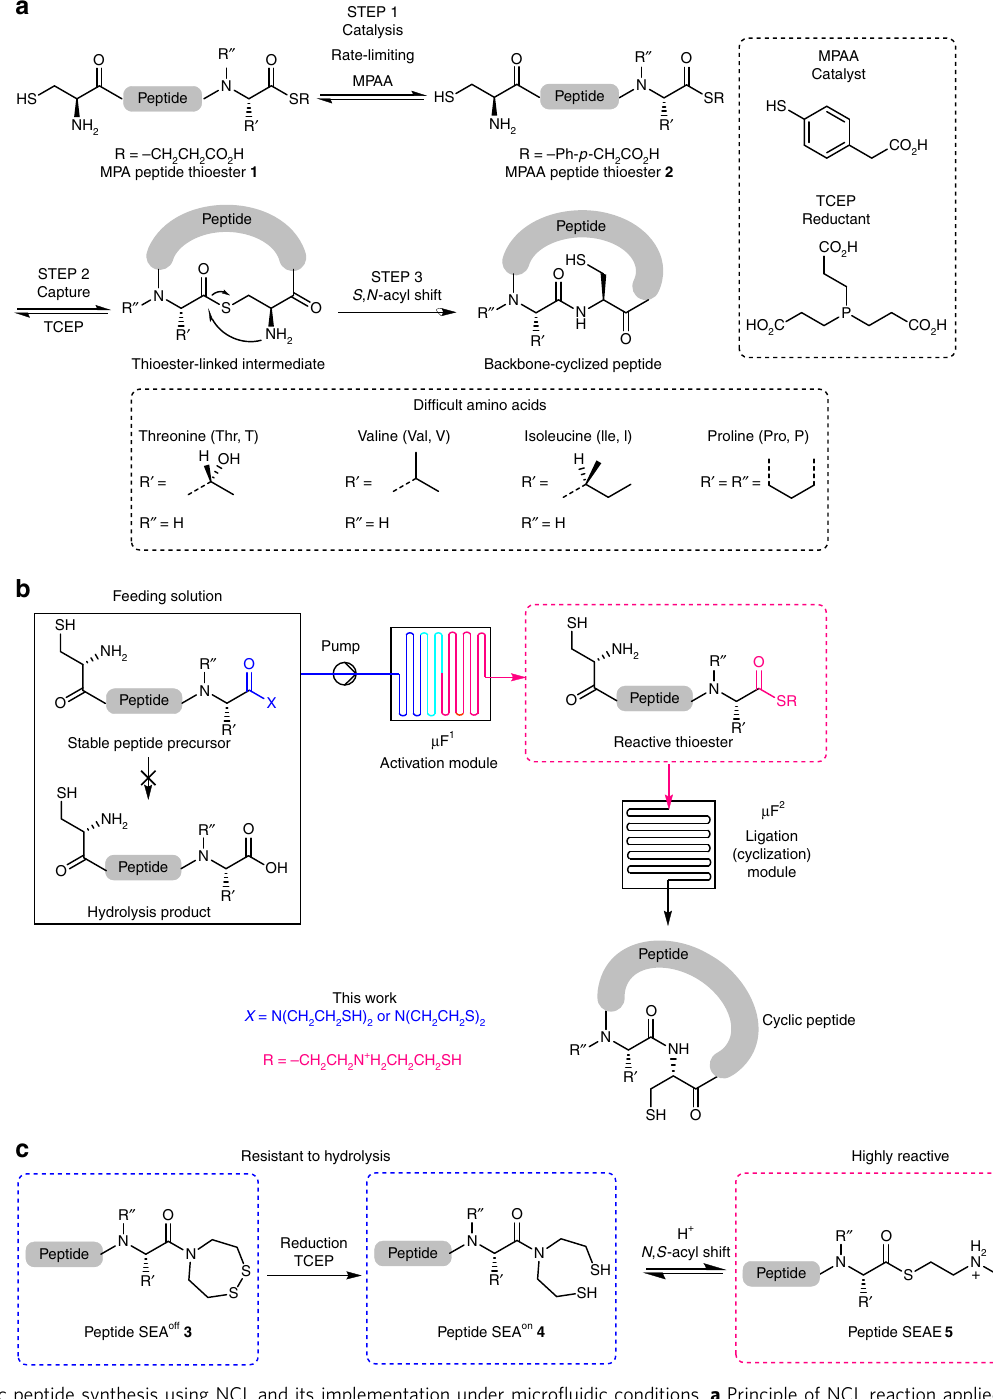
Fig. 1 Cyclic peptide synthesis using NCL and its implementation under micro fl uidic conditions. a Principle of NCL reaction applied to cyclic peptide synthesis. The NCL reaction involves the chemoselective reaction of a C-terminal peptide alkylthioester (e.g., MPA peptide thioester 1 ) or arylthioester (e.g., MPAA peptide thioester 2 ) with an N -terminal cysteinyl peptide. The intramolecular version of this reaction enables backbone cyclization. The ligation proceeds in the presence of an exogenous thiol catalyst (typically MPAA) and a reductant (typically TCEP). b Implementation of NCL under micro fl uidic conditions toward backbone peptide cyclization. The system is fed with a stable precursor, which is activated into a highly reactive thioester species before entering the ligation module. c Reactive SEAE peptide thioesters are generated from the stable SEA cyclic disul fi de (SEA off ) 3 upon reduction with TCEP or from the reduced SEA on bisthiol 4 . SEAE peptide thioesters 5 enable extremely fast NCL even with dif fi cult C-terminal amino